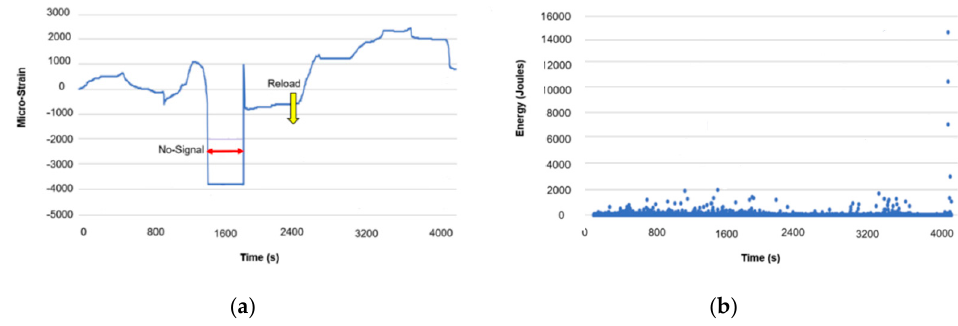
Figure 9. Micro-strain and AE energy over time in compression mode under single load test ( a ) micro-strain; ( b ) AE energy.